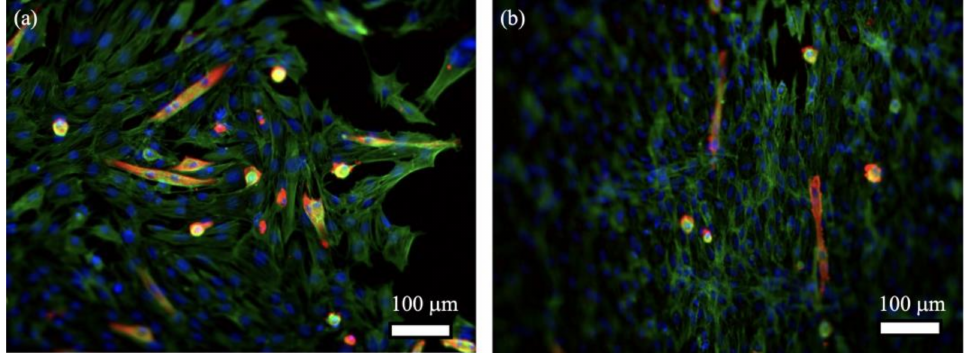
Figure 7. Fluorescence images of C2C12 cells cultured for 4 days in serum-rich and 7 days in low- serum DMEM on ( a ) 20 mg.mL − 1 fibrin; ( b ) 20 mg.mL − 1 fibrin with 10 mg.mL − 1 collagen (Blue: DAPI, green: Alexa Fluor 488 Phalloidin, red: MF20- Alexa Fluor 546).